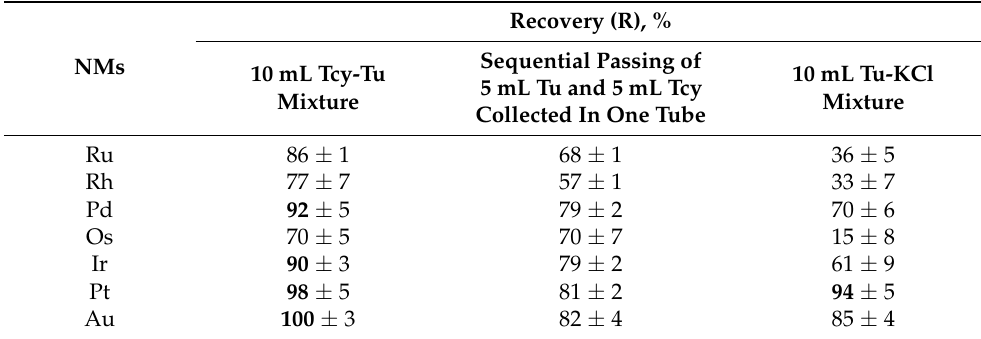
Table 6. Difference of efficiency between Tcy-Tu mixture, Tu-KCl mixture, and sequential Tu and Tcy solutions, with the sum of concentrations of components equal to 1.0 M and a ratio of 1:1 (all solutions contain 0.5 M HCl acid) passing through the sorptive column ( n = 3, p = 0.95).